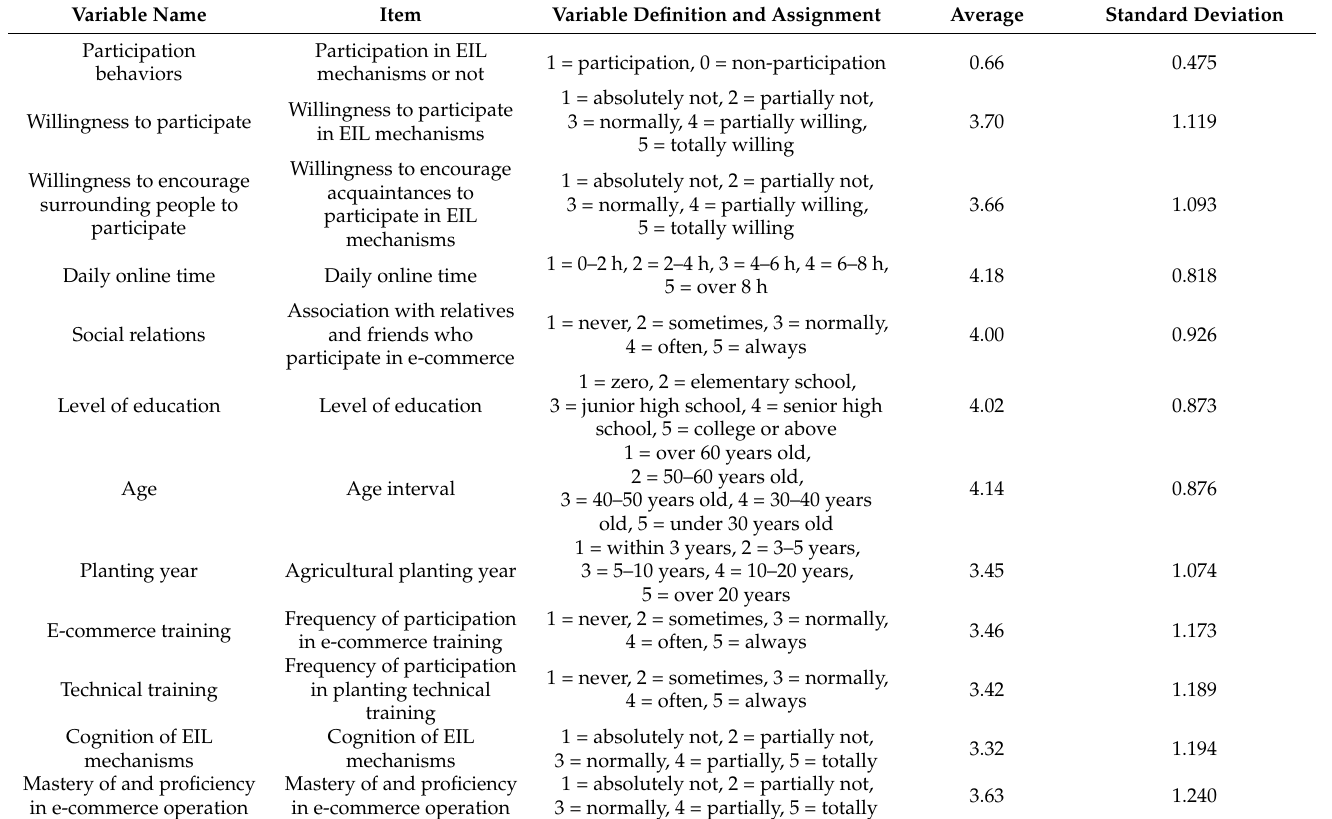
Table 3. Variable definitions and descriptive